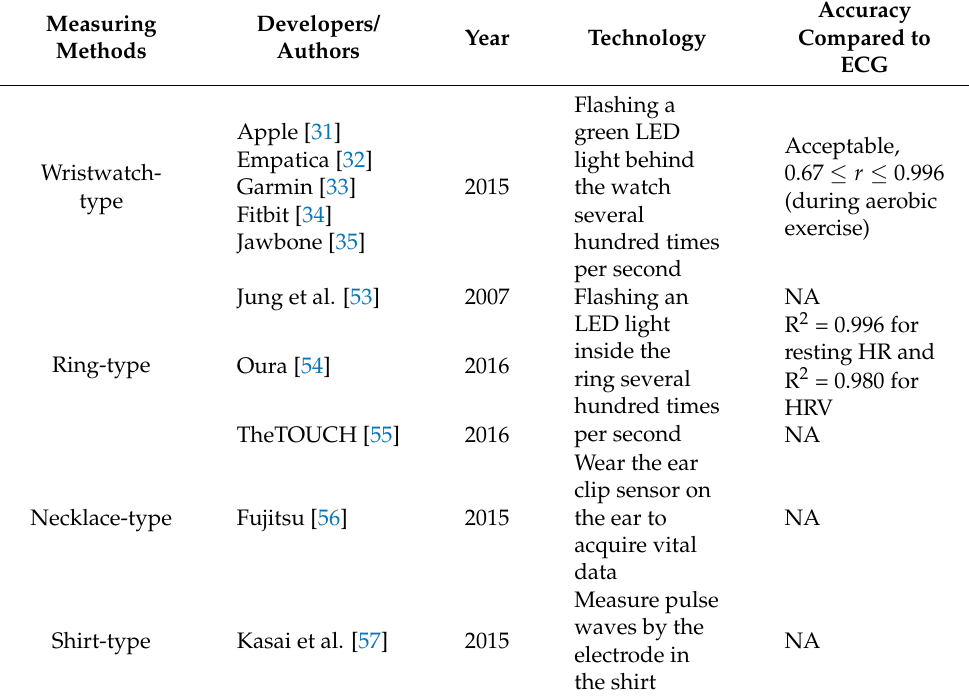
Table 3. Comparison table of wearable-type heartbeat measuring methods in this review. NA means that no description of accuracy can be